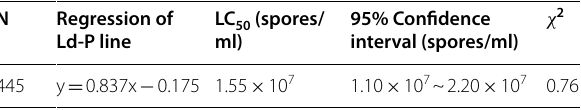
LC 50 values (72 h mortality) calculated by probit analysis. 95% confidence interval in parentheses were based on three replication